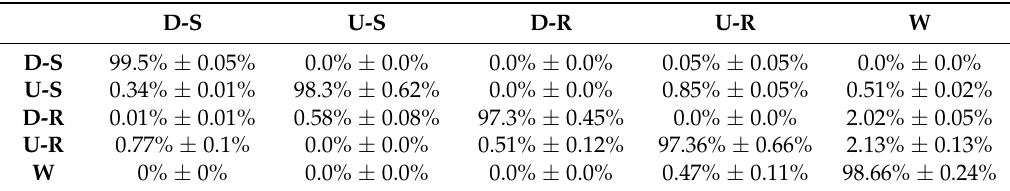
Table 4. Confusion matrix for experimental results with MVA under